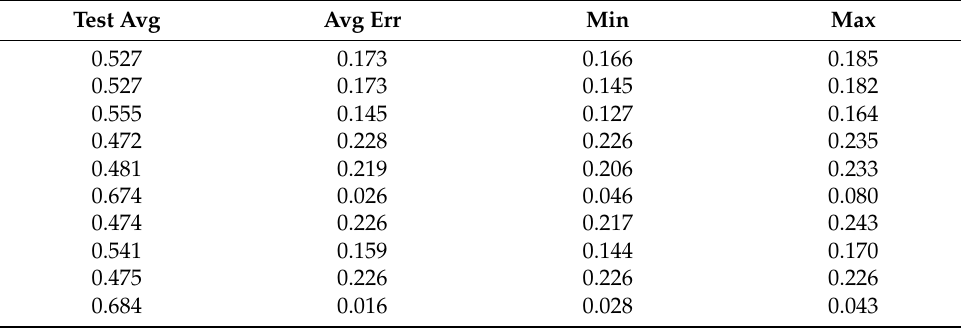
Table A53. Set 1, trials 31–40 data (all 0.5 PR